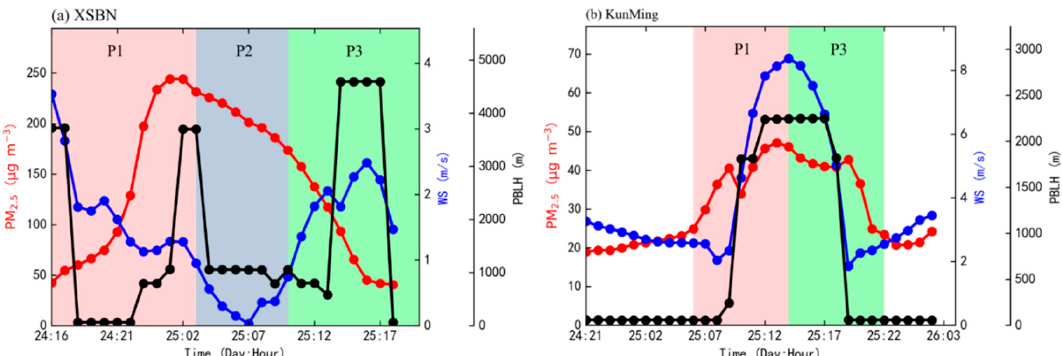
Figure 7. Hourly variations in PM 2.5 concentrations (red lines), wind speed (WS, blue lines), and planetary boundary layer height (PBLH, black lines) at two representative sites: ( a ) XSBN in SR and ( b ) Kunming in RR, from 16:00 of 24 March to 03:00 of 26 March. P1, P2, and P3 indicate the formation, maintenance, and dissipation periods of the air pollution episode, respectively.